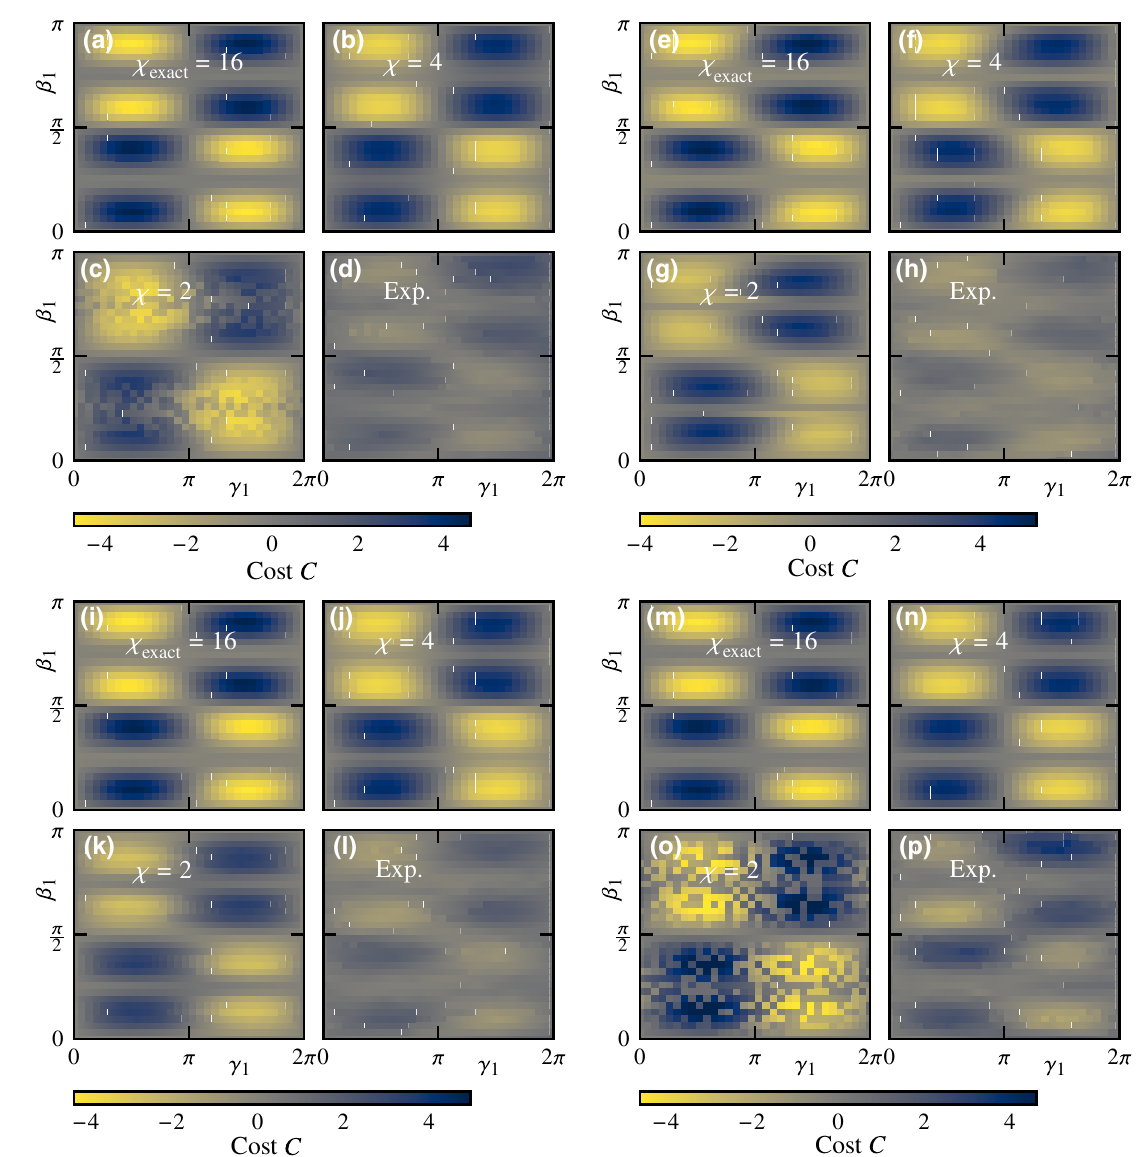
FIG. 10. The cost landscape for N = 8 unit-weight 3-regular graphs versus the two parameters γ 1 and β 1 of a one-layer QAOA cir- cuit—a comparison of the matrix-product-state simulations with χ ≡ χ exact = 16, χ = 4, χ = 2 together with the quantum processor output (Rigetti Aspen-M-1): (a)–(d) the 3-regular graph of Fig. 5(f); (e)–(h) the 3-regular graph of Fig. 5(d); (i)–(l) the 3-regular